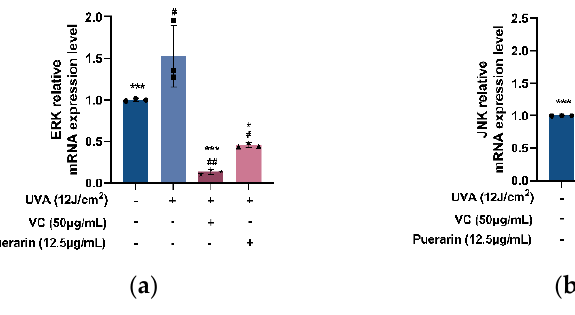
Figure 5. Effects of puerarin on UVA ‐ induced mitogen ‐ activated protein kinase (MAPK) signaling in HSF: ( a – c ) RT ‐ PCR analysis of human extracellular signal ‐ regulated kinase (ERK), human c ‐ Jun amino ‐ terminal kinase (JNK), and P38 mRNA expression levels after treatment and UVA irradiation of samples. # p < 0.0 5 , ## p < 0.0 1 as compared to the control group; * p < 0.05, ** p < 0.01, *** p < 0.001 as compared to the damage model group; Values do not have a common mark ( # , *) when p > 0.05, ( n = 3).